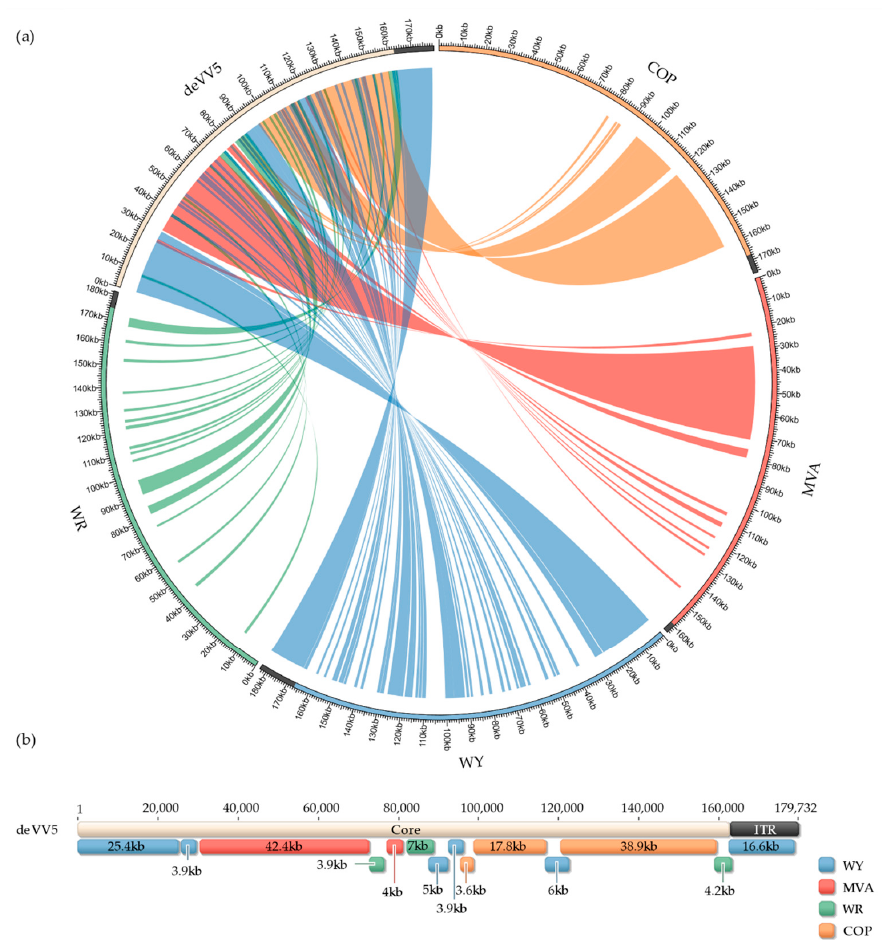
Figure 3. Homology maps between deVV5 and each parental genome. ( a ) De novo sequenced viral genomes are shown around the circos plot (COP, orange; MVA, red; WY, blue; WR, green; deVV5, white). Only one ITR is displayed (black). Blast results of deVV5 regions greater than 1 kb with 100% identity are linked by color-coded ribbons to the corresponding hit. ( b ) deVV5 genome annotated with results from global pairwise alignments. Each annotation corresponds to the longest region with 100% identity to the corresponding parental genome. deVV5 core and single ITR region are also displayed.